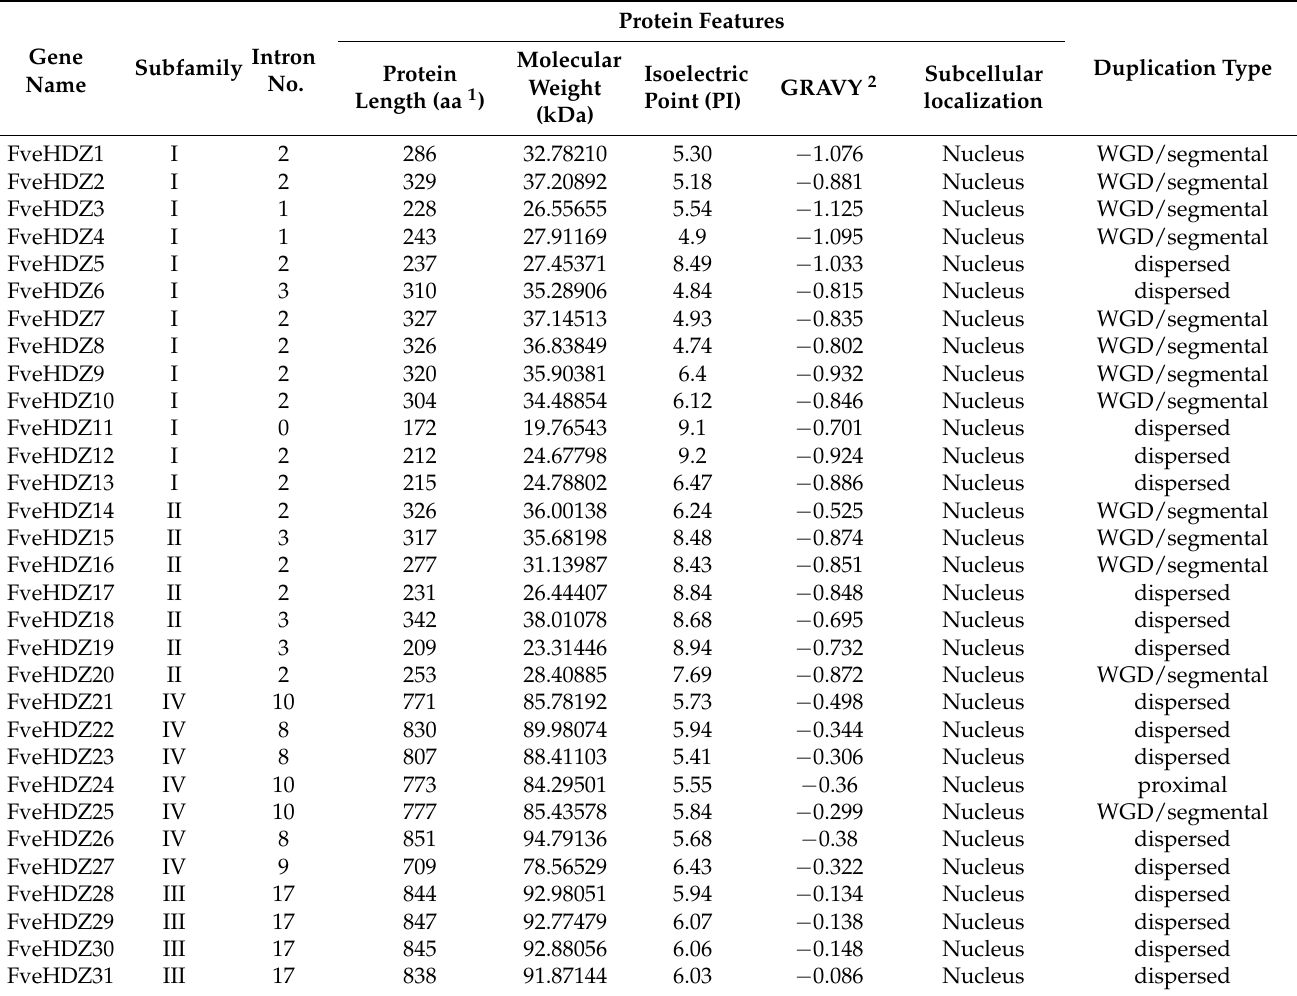
Table 1. Characteristics of the putative HD-Zip family members in F. vesca